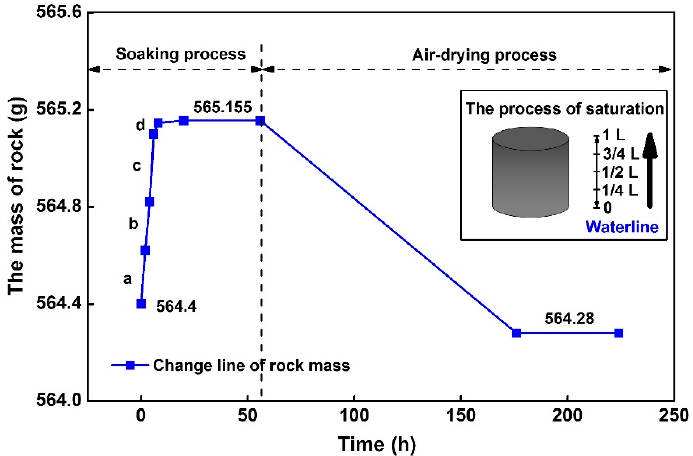
Figure 4. Mass change of one of the rock samples after the first wet-dry cycle.